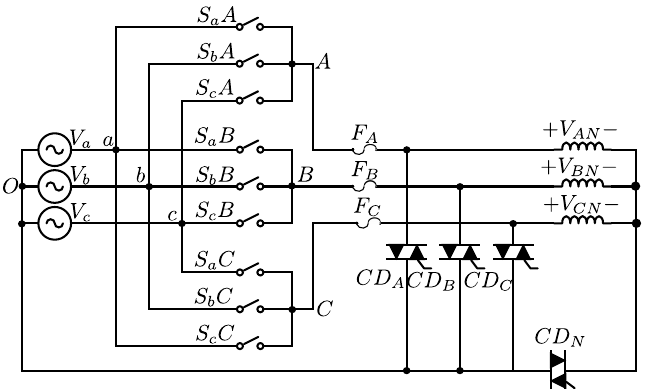
Figure 16. Matrix converter structure with short-circuit and open-circuit fault tolerance. When the system controller detects a fault ( S a A for instance), the two remaining switches in the faulty output leg ( S b A and S c A ) open to avoid the short circuit condition of the other power sources. The connecting device linked to the output leg with the short-faulted switch ( CD A ) is then triggered. As a result, the short-circuit condition is redirected through the input voltage V a , the short-failed switch S a A , the connecting device CD A , and the fast-acting fuse F A that is finally burned.